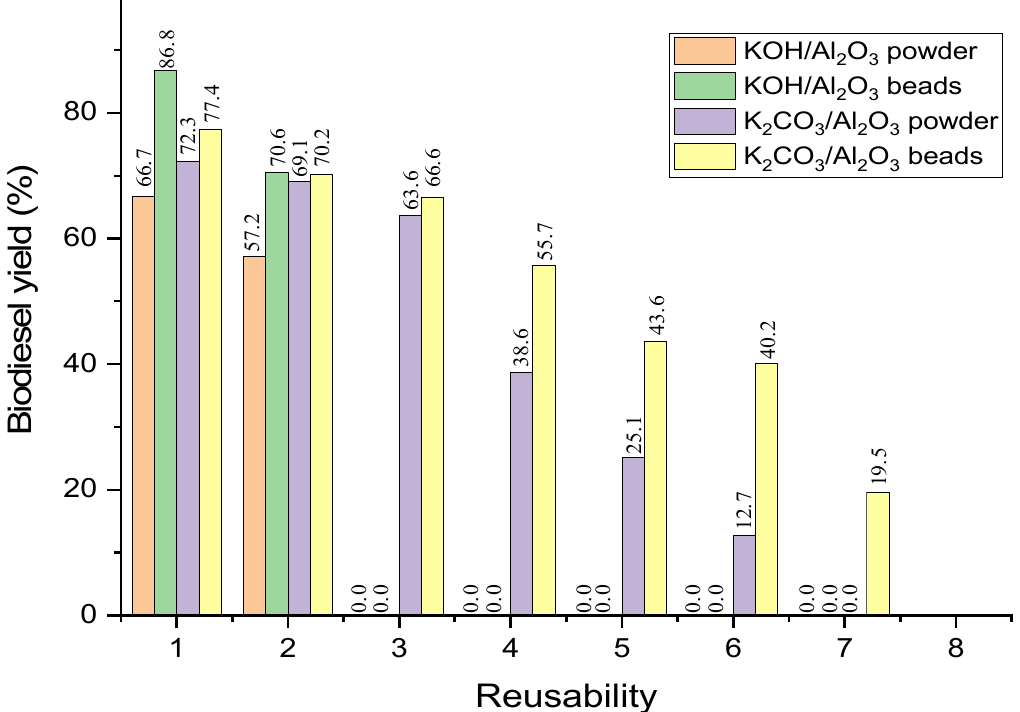
Figure 8. Reusability testing for K 2 CO 3 /Al 2 O 3 and KOH/Al 2 O 3 catalyst.